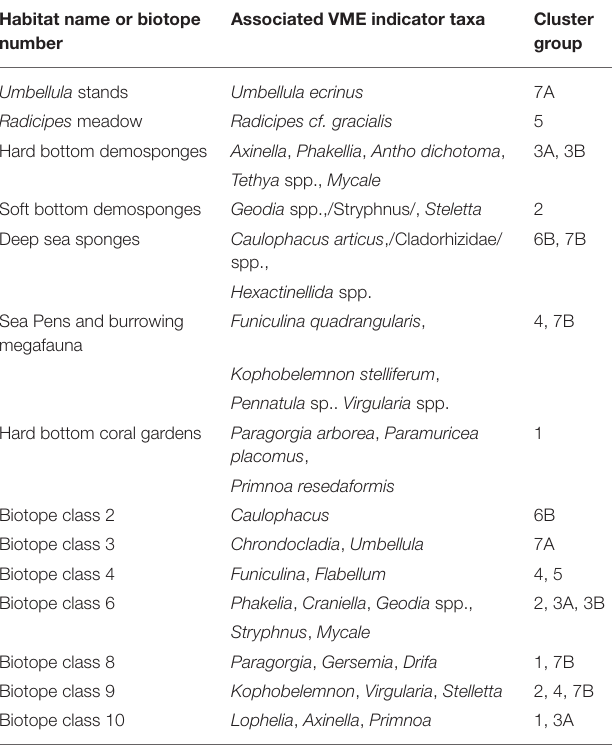
TABLE 5 | Biotopes identified in the Norwegian shelf by Elvenes et al. (2014) and Gonzalez-Mirelis and Buhl-Mortensen (2015) with associated VME indicator taxa, and the cluster dendrogram groups in which those taxa were assigned in our